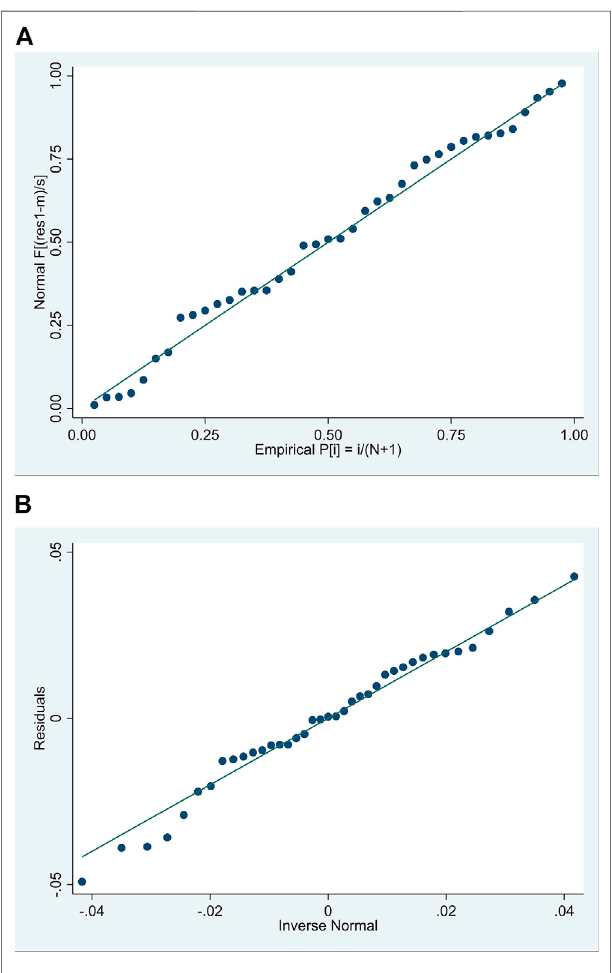
FIGURE 3 | (A) Standardized normal probability plot. (B) Quantiles of residuals against quantiles of normal